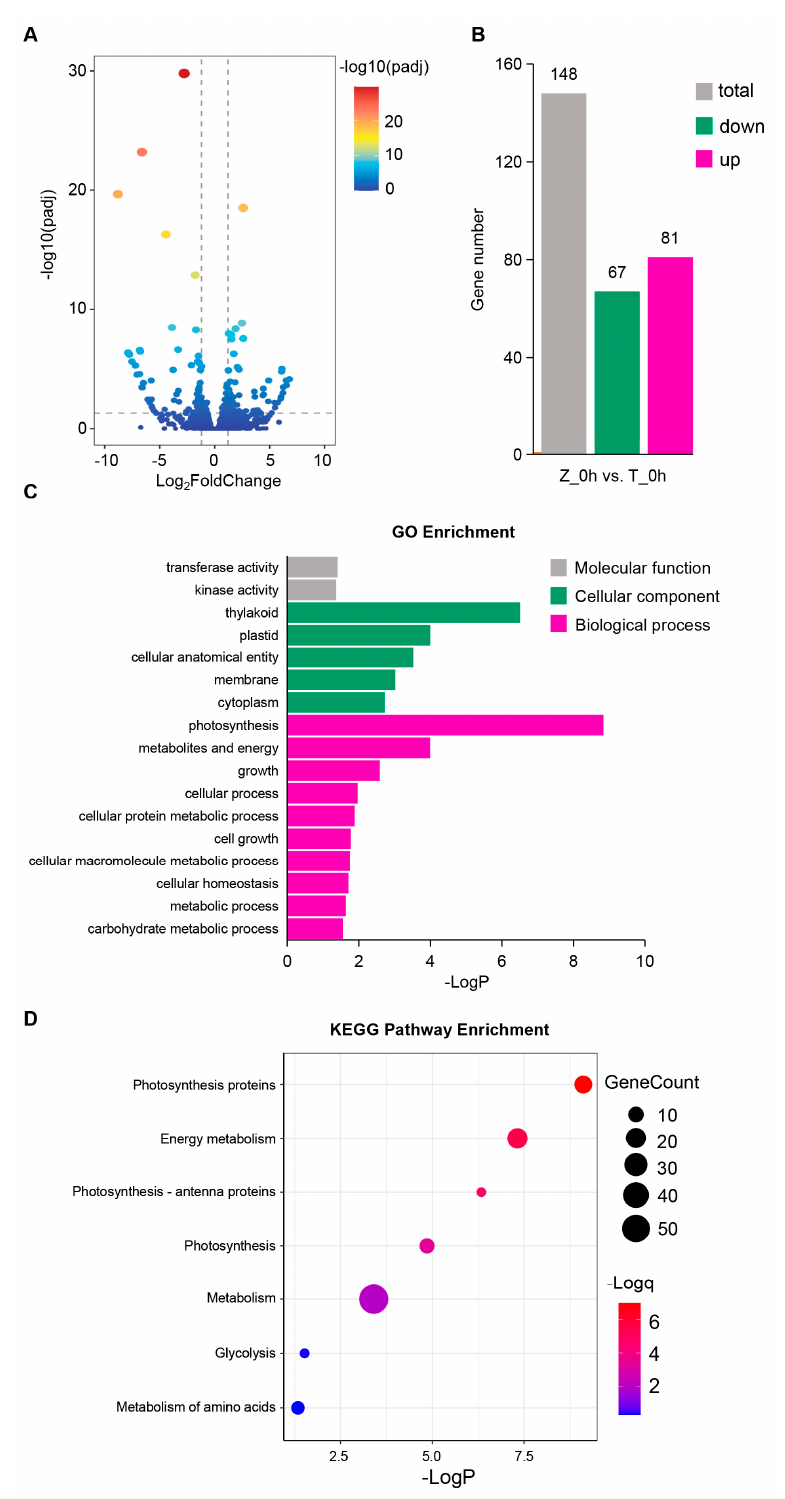
Figure 3. Analysis of differentially expressed genes (DEGs) between Towada and ZL31 at the 0 h cold treatment. ( A ) Volcano plot showed DEGs by ZL31 vs. Towada at 0 h ( p < 0.01 and |Log 2 FoldChange| > 1). ( B ) The numbers of up − regulated (Magenta) and down − regulated (green) genes in ZL31 compared with Towada at 0 h cold treatment. ( C , D ) GO and KEGG pathway enrichment analysis of 148 DEGs. − LogP and − Logq represent the significance of GO and KEGG